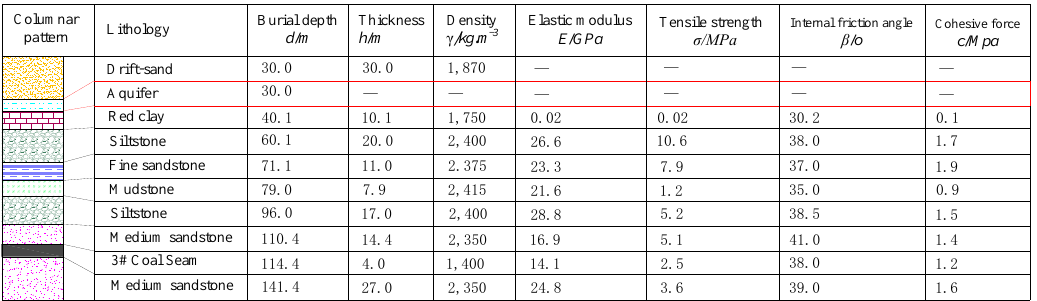
Figure 8. Columnar patterns of the strata and the related physical and mechanical properties.